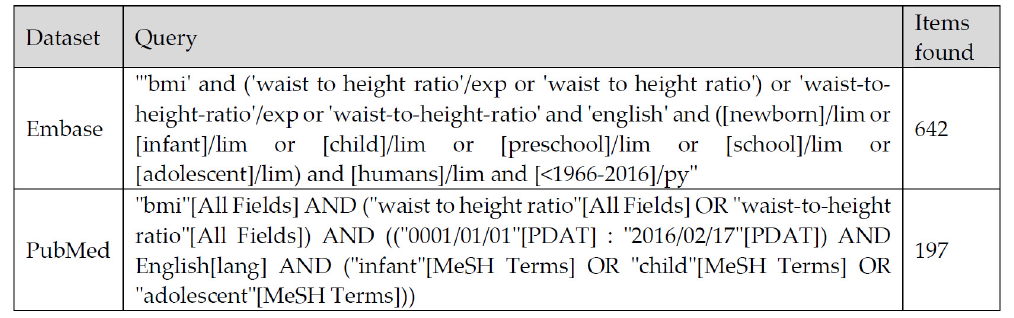
Figure 1. Search strategy based on Key words for PubMed/Medline and Embase databases.